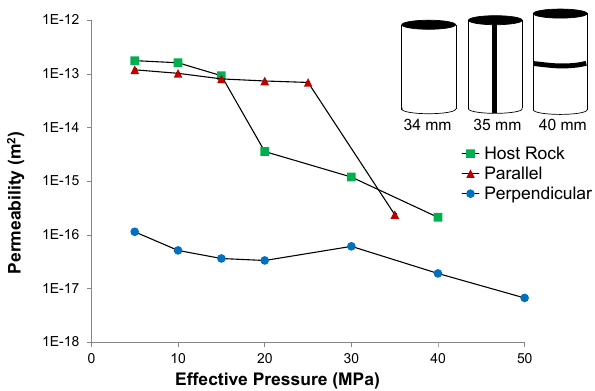
Fig. 4. Shear zone permeability. Steady-state water permeabil- ity measured at effective pressures of 5–50MPa for sample cores (2.5cm diameter) with no shear band (host rock), and drilled par- allel and perpendicular to the pseudotachylyte-bearing shear band (inset). When the pseudotachylyte is parallel to flow, the flow rate is still controlled by the host rock, but when the vein runs perpen- dicular to flow it controls the permeability, which is reduced. Ad- ditionally permeability is reduced as effective pressure is increased and cracks are accordingly closed, this effect is less apparent in the perpendicular-cut sample as the porosity of the pseudotachylyte is already negligible.